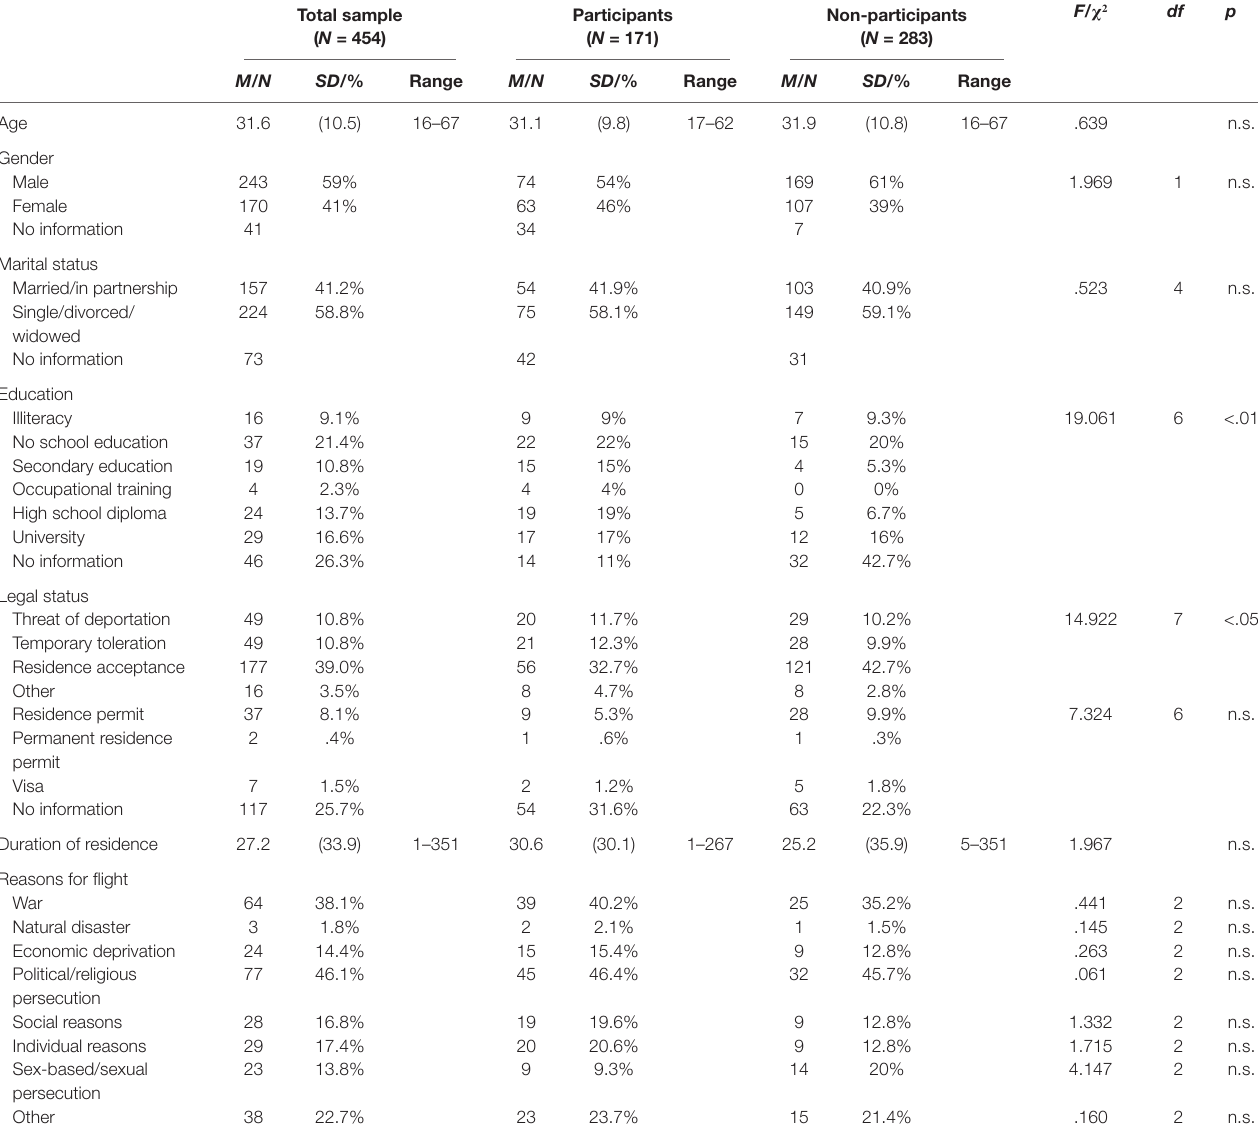
TABLE 1 | Sociodemographic and flight-specific characteristics for participating and non-participating refugee patients (ANOVA and chi-squared